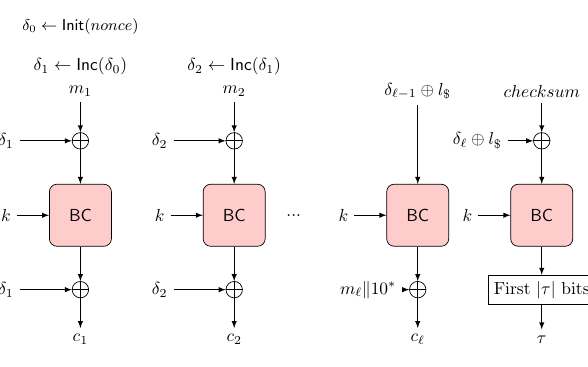
Figure 1: OCB encryption mode (when the last message block is not full).